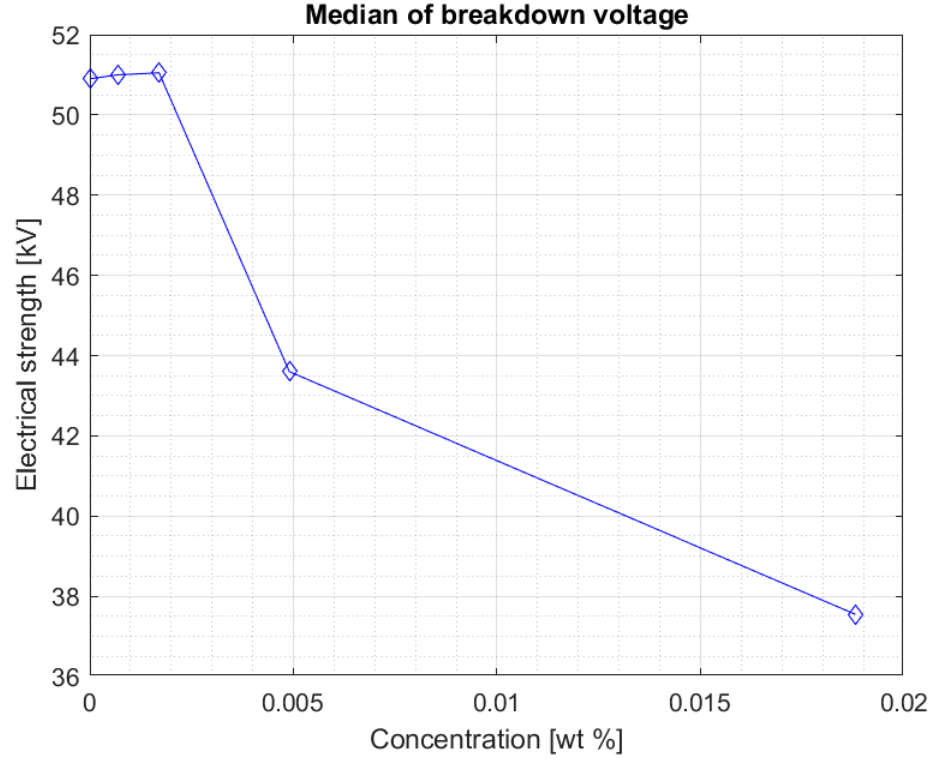
Figure 4. Median of measurement results for each nanofluid five weeks after mixing.